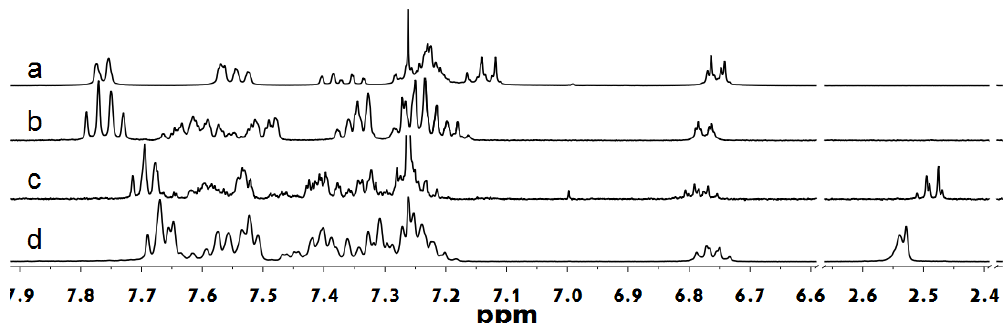
Figure 1. 1 H NMR spectra of TFO8 in CDCl solutions; ( b ) CD OD and ( c , d ) CDCl 3